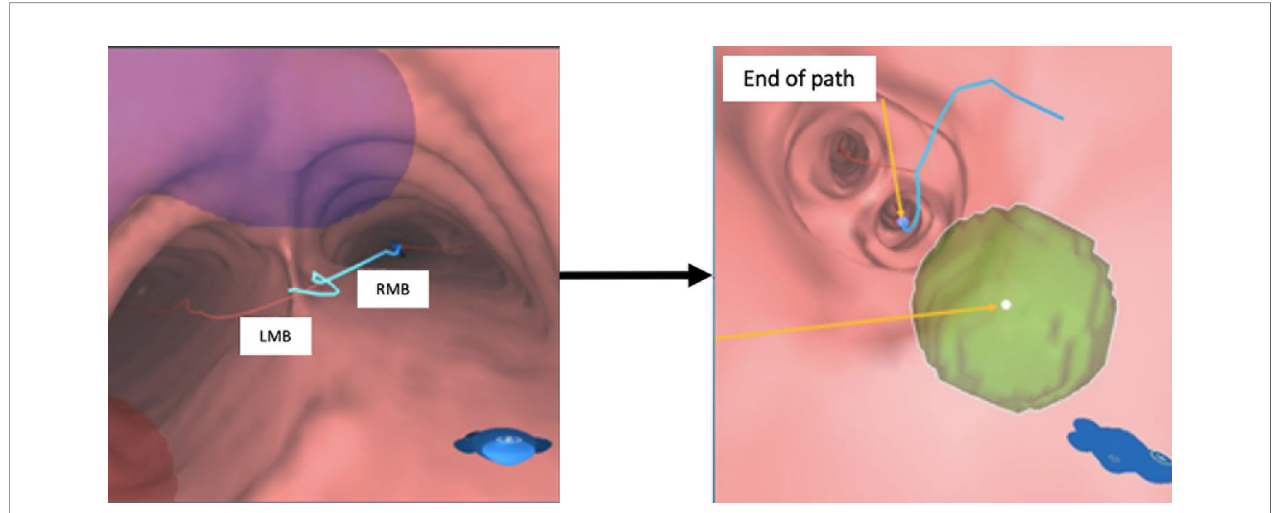
FIGURE 5 | VBN simulation in the pre-planning system. Left: animated simulation of the VBN guidance. Right: at the end of the route, virtual FM positions are reachable. VBN, virtual bronchoscopic